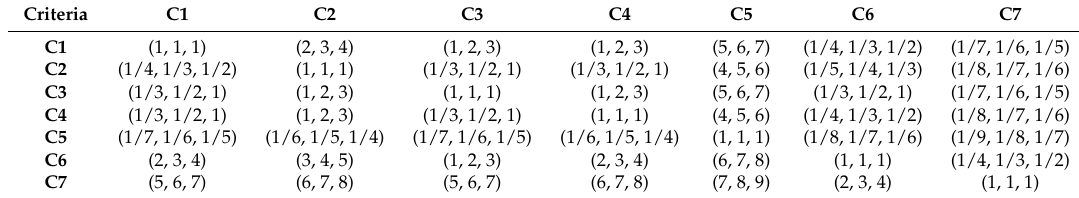
Table 6. Fuzzy Comparisons for each criteria (Expert 4).